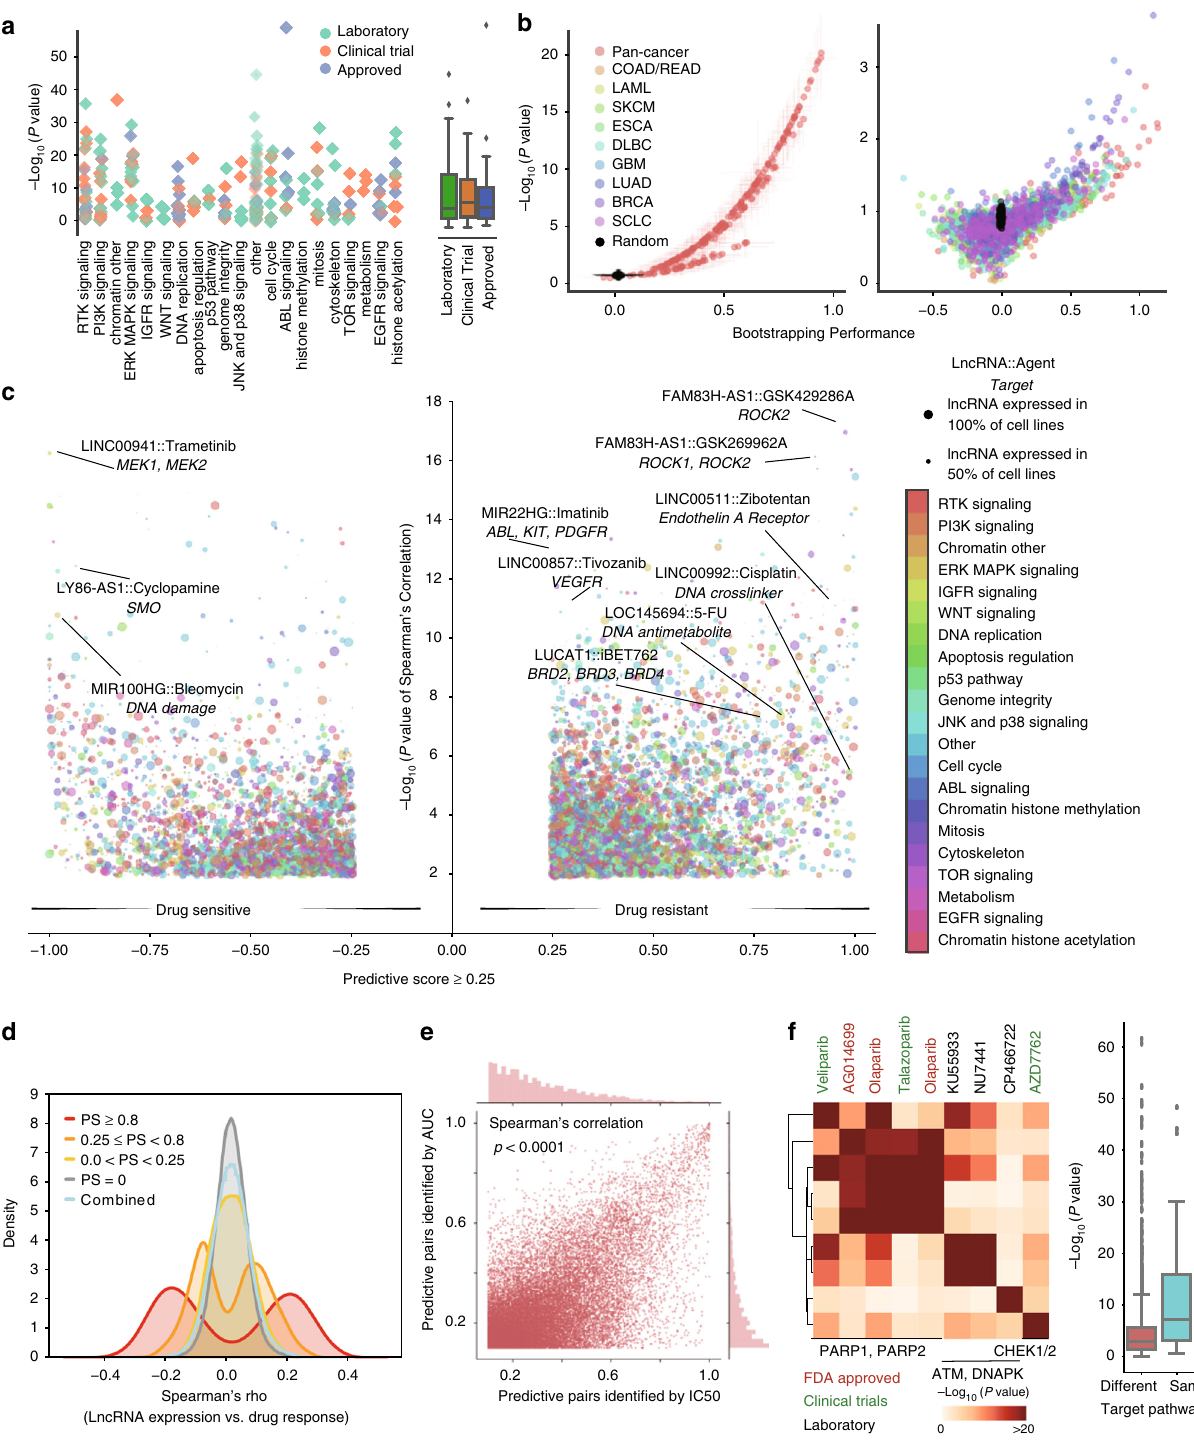
Fig. 2 The landscape of LncRNA-drug predictive pairs in cancer cell lines. a Effect of cell lineage on drug response prediction for each agent. The linage effect is evaluated using one-way ANOVA, and negative log10-transformed p -values are indicated on y -axis. The agents are organized based on targeting pathways ( x -axis). b Volcano plot of pan-cancer models (left) and cancer-speci fi c models (right) performance in drug response prediction in the bootstrapping process. Pearson correlation coef fi cients ( x -axis) and negative log10-transformed p -values ( y -axis) indicate the model performance. c lncRNA-drug predictive pairs landscape across 265 agents and 505 cancer cell lines. The predictive score for each lncRNA-drug interaction and the negative log-transformed p -value for Pearson ’ s correlation between the lncRNA expression and IC50 were shown in the y -axis and x -axis of the volcano plot. d The distribution of Spearman ’ s correlation coef fi cients between lncRNA expression and ln-transformed IC50s. The density plot of the coef fi cients is shown for (i) strong predictive pairs with PS > = 0.8; (ii) moderate predictive pairs with 0.25 < = PS < 0.8; (iii) weak predictive pairs with 0 < = PS < 0.25; (iv) non-predictive pairs and (v) the combination of all lncRNA-drug pairs. e Scatter plot of the predictive score between lncRNA-drug predictive pairs identi fi ed in IC50 models and those identi fi ed in AUC models. f Agents targeting genome integrity clustered by shared predictive lncRNA signatures. One- sided Fisher exact test p -values were indicated by different colors in the heatmap NATURE COMMUNICATIONS| (2018) 9:3192 |DOI: